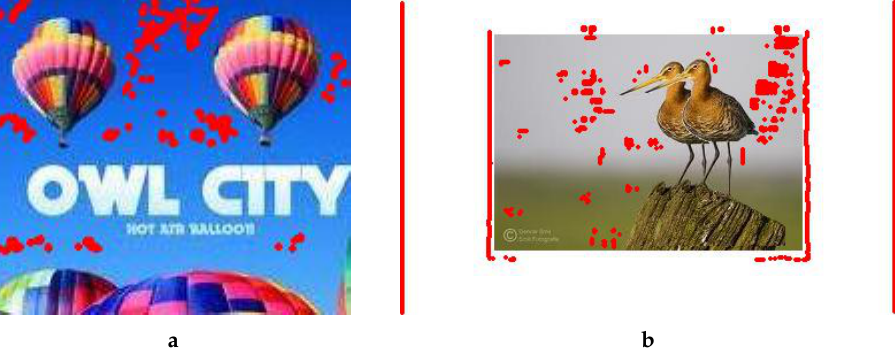
Figure 12. Forgery detection results provided by the authors of Meena’s method. ( a ) Forged balloon image, ( b ) Forged birds image (the copyright logo is visible on the tested forged version; for better viewing, a cropped version of the image is used in Figure 5a).